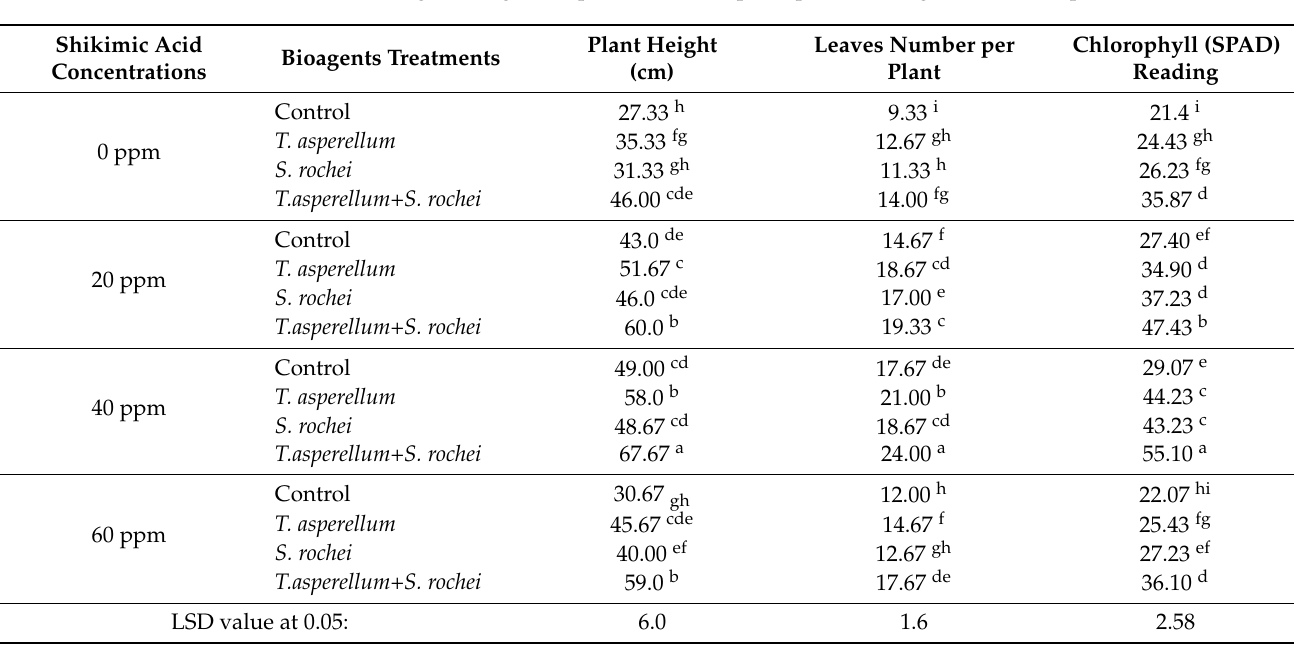
Table 3. Effect of the interaction between seed priming of shikimic acid (0, 20, 40, 60 ppm) and foliar applications with S. rochei (SR), T. asperellum (TS), S. rochei + T. asperellum (SR + TS), and water (control) on the vegetative growth parameters of squash plants during the second